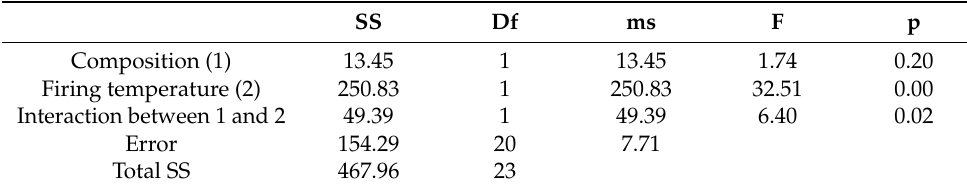
Table 11. Analysis of variance of flexure strength of studied compositions.